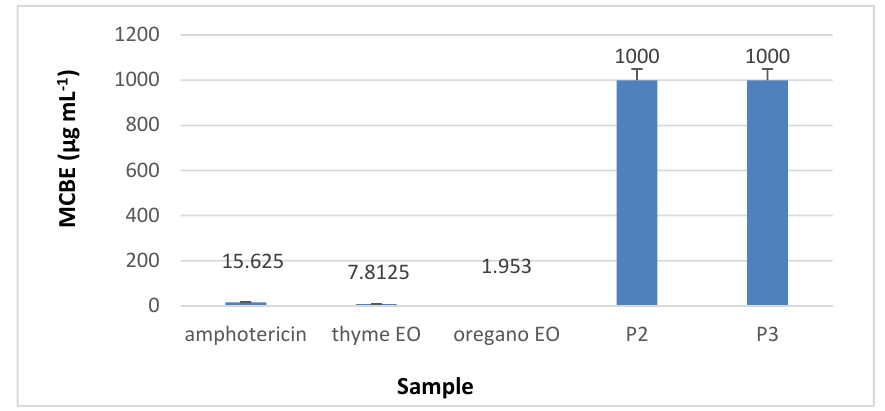
Figure 17. MCBE of collagen nanofibres loaded with essential oils against C. albicans ATCC 10231, as compared to amphotericin and essential oils.